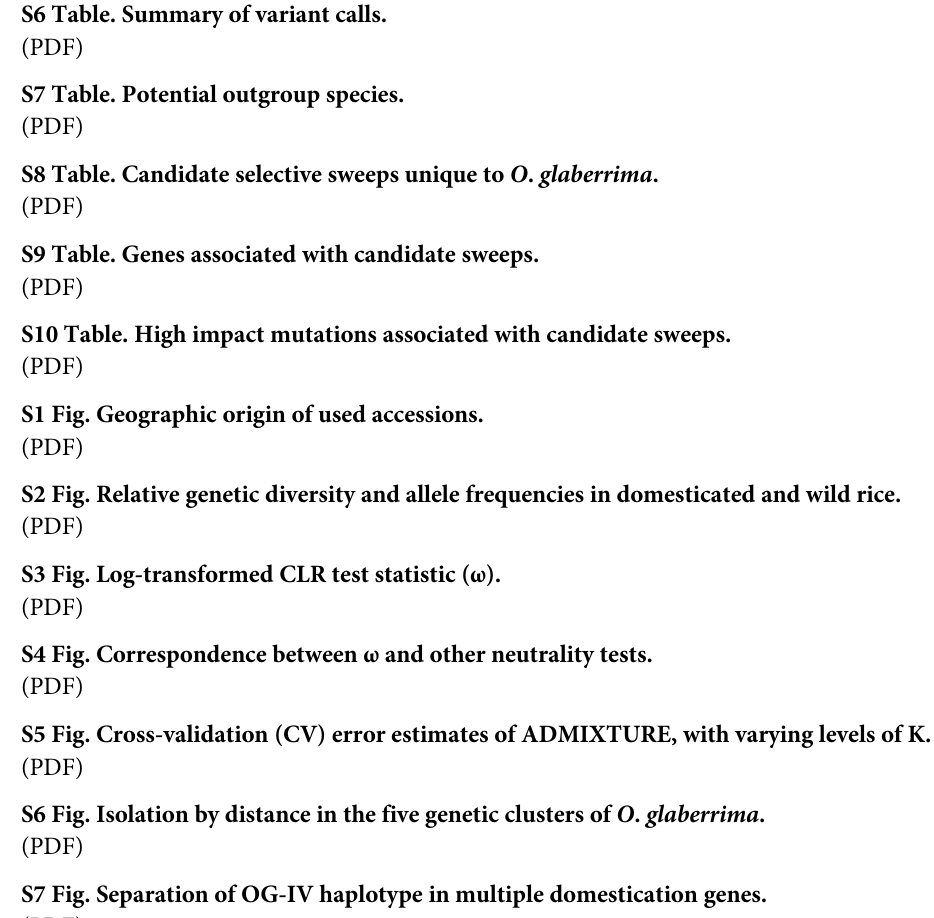
S6 Fig. Isolation by distance in the five genetic clusters of O . glaberrima . S7 Fig. Separation of OG-IV haplotype in multiple domestication genes. S8 Fig. SNP count and Ts:Tv ratio grouped by filter class. (PDF) S9 Fig. Effect of filtering thresholds on nucleotide diversity and fixation index.